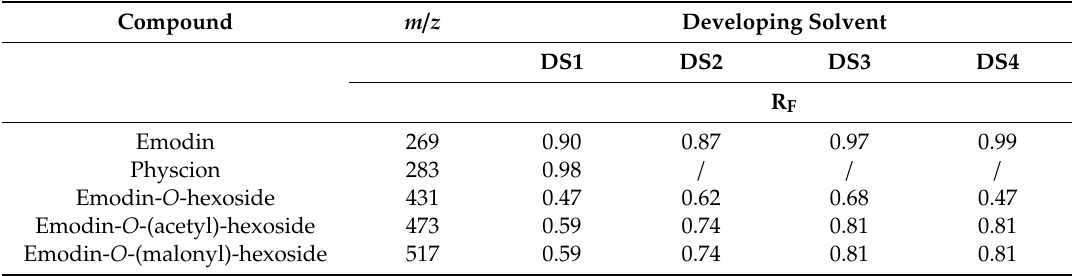
Table 3. R F values of anthraquinones identified by HPTLC-MS analyses in Japanese knotweed rhizomes with di ff erent developing